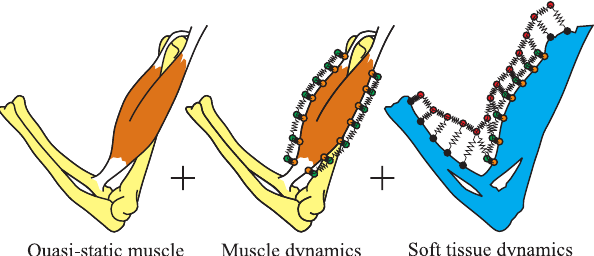
Fig. 1 The three models used in our skin deformation model. Left: the quasi-static muscle model that determines the quasi-static muscle shape. Middle: the muscle dynamics model that determines the dynamic deformation of muscles. Right: the soft tissue dynamics model that determines the dynamic deformation of fat and